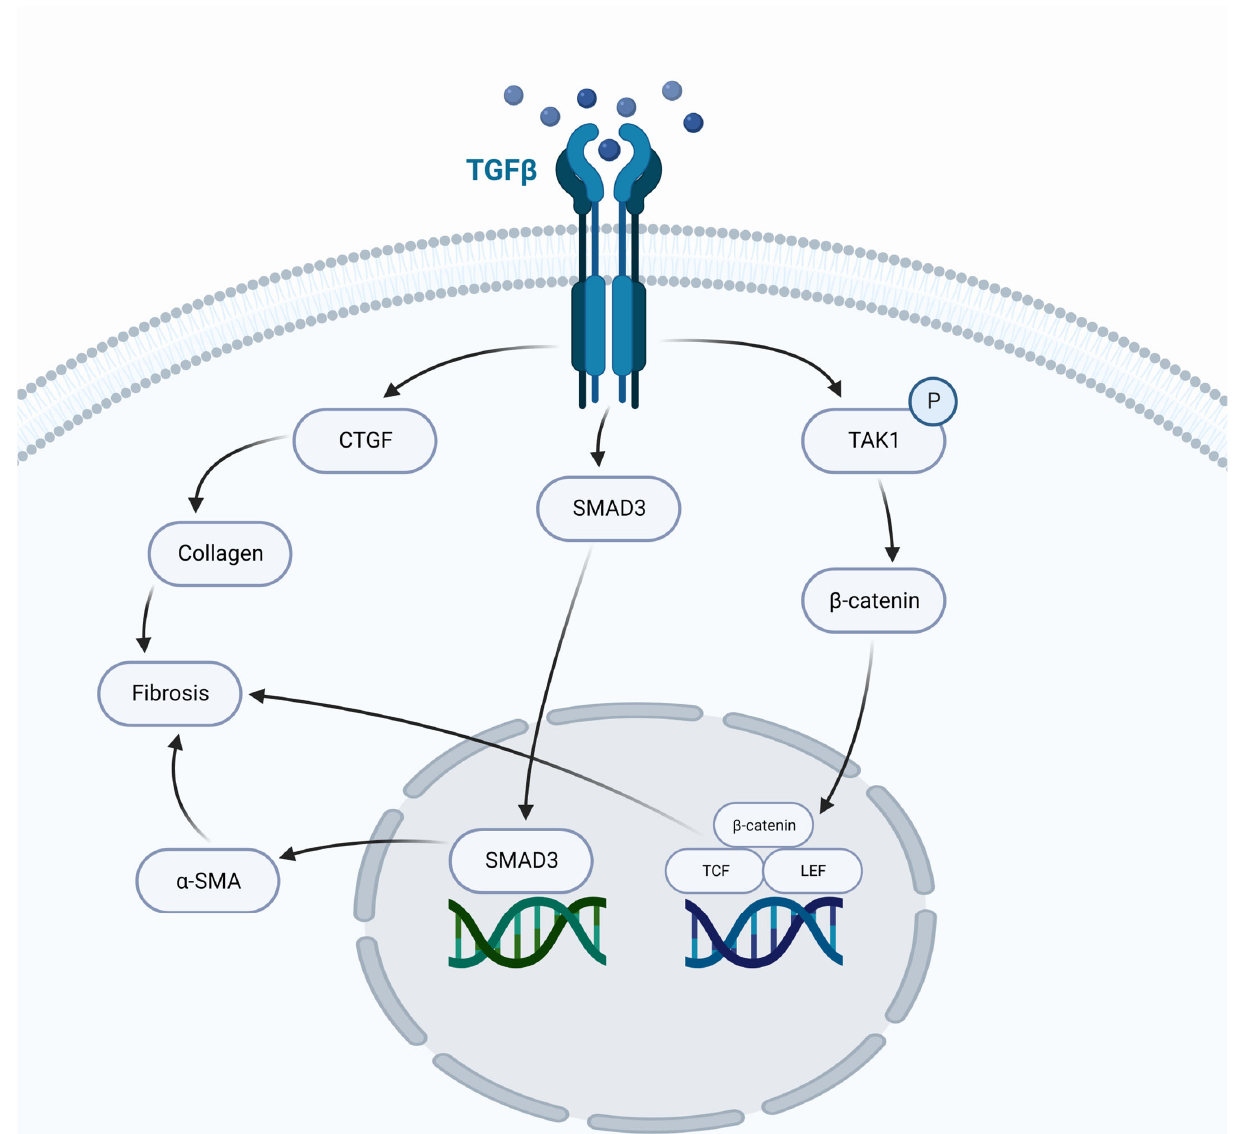
Figure 4. TGF- β pathways in cardiac fibrosis. Transforming growth factor beta (TGF- β ) acts through several pathways to induce fibrosis in cardiac tissue. TGF- β induces the production of connective tissue growth factor (CTGF) which increases collagen production, ultimately ending in increased fibrosis. The wingless-related integration site (Wnt) pathway activates transforming growth factor- β activated kinase (TAK1), which auto-phosphorylates to increase β -catenin activity. β -catenin translocates to the nucleus where it acts as a transcription factor with T-cell factor (TCF) and lymphoid enhancer factor (LEF) to increase transcription of fibrogenic target genes. The traditional TGF- β pathway increases mothers against decapentaplegic 3 (SMAD3) activity, which is also a transcription factor that increases production of alpha smooth muscle actin ( α -SMA), a protein observed in mature fibroblasts, and induces production of tissue fibrosis. Figure created with BioRender. TNF- α binds two receptors on cardiac myocytes, tumor necrosis factor receptor I (TNFRI) and tumor necrosis factor receptor II (TNFRII) (Figure 5). TNFRI is responsible for initiating fibrosis from many causes by increasing renin-angiotensin activity and the expression of angiotensin II receptor 1 (Figure 5) [54]. The renin-angiotensin-aldosterone system (RAAS) is known to cause fibrosis and cardiac remodeling; hence angiotensin converting enzyme inhibitors (ACE)/angiotensin receptor blockers (ARBs) are a part